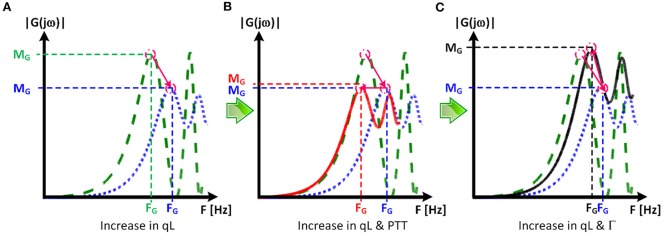
Parametric sensitivity of the frequency response associated with the tapered tube-load (TL) model. (A) An increase in the tapering constant (qL) decreases the amplitude MG of the first peak in the frequency response while increasing its frequency coordinate FG. Green dashed line: frequency response of uniform TL model. Blue dotted line: frequency response of tapered TL model (qL > 0) with pulse transit time (PTT) and reflection constant (Γ) identical to uniform TL model. (B) An increase in the PTT in the tapered TL model decreases FG. Red solid line: frequency response of tapered TL model in (A) with larger PTT. (C) An increase in the reflection constant in the tapered TL model increases MG while decreasing FG. Black solid line: frequency response of tapered TL model in (A) with larger reflection constant.